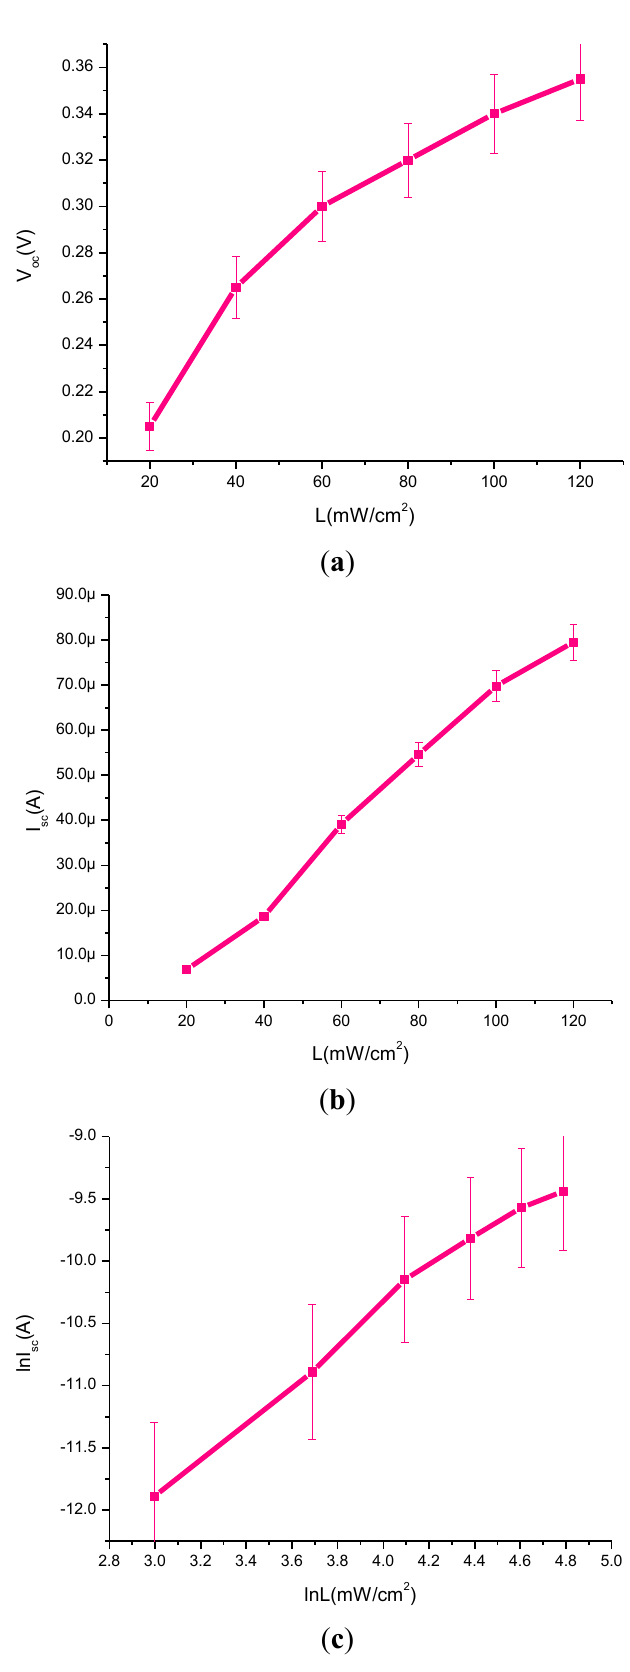
Figure 4. Plots of ( a ) V oc vs. light intensity, ( b ) I sc vs. light intensity and ( c ) ln( I SC ) vs. ln( L